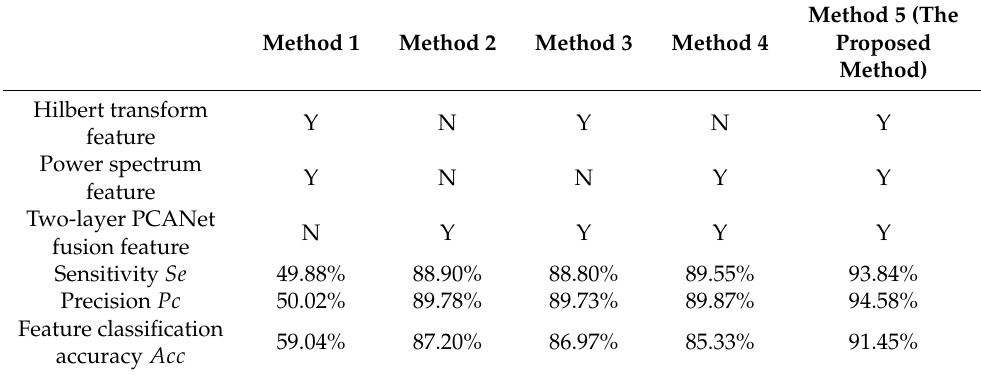
Table 2. Comparison for recognition performance of different feature extraction models.